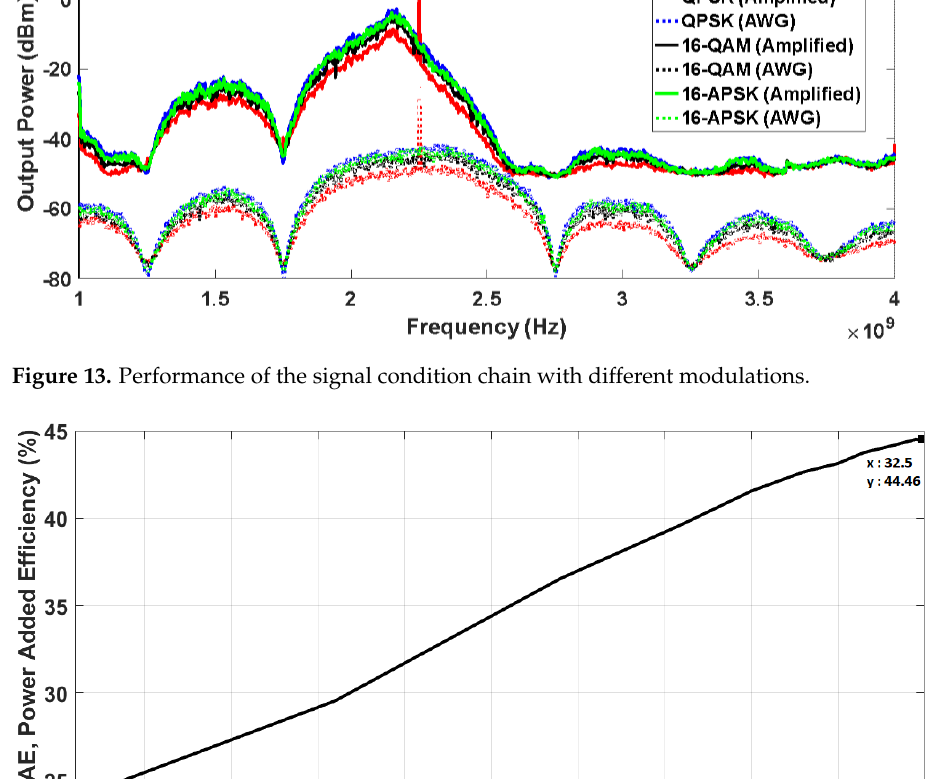
Figure 14. PAE of the signal conditioning stage.